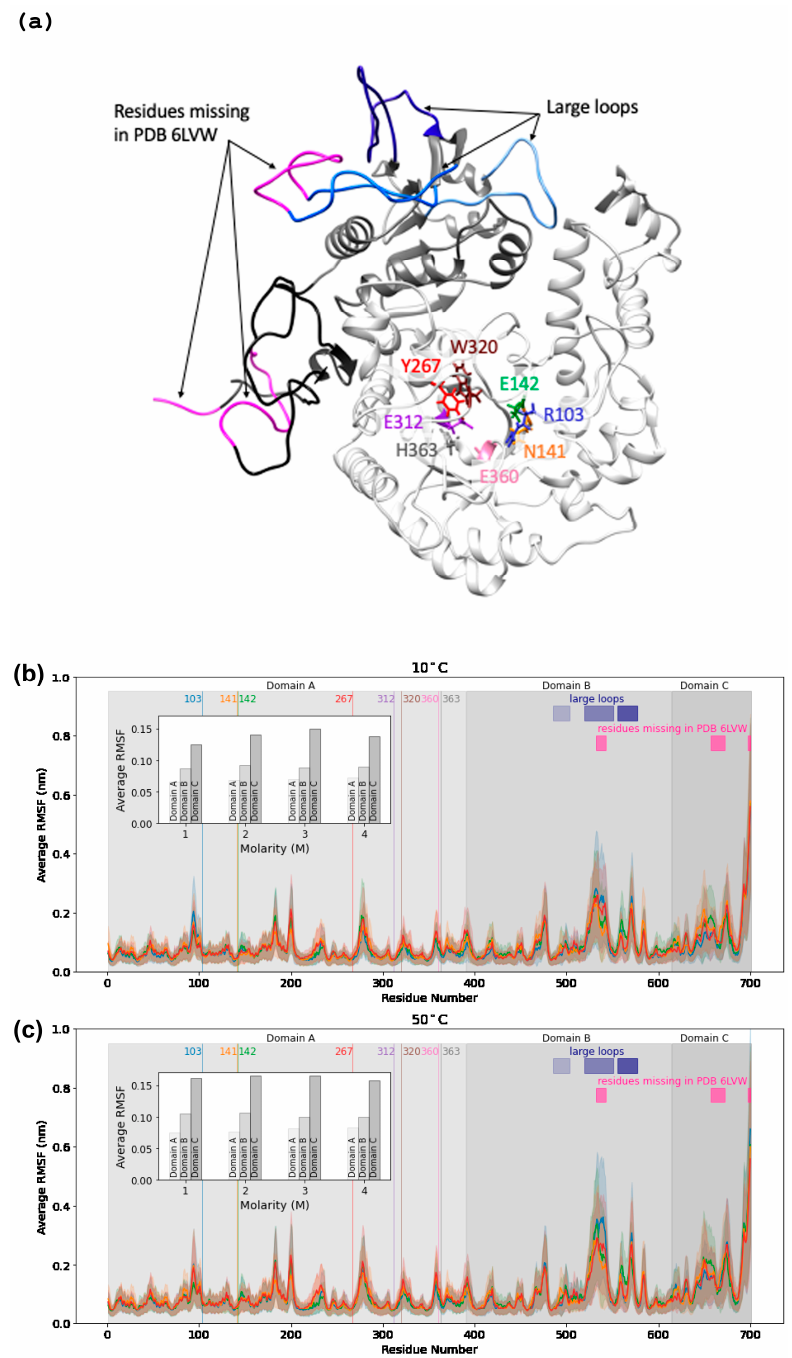
Figure 3. The structure of H. lacusprofundi β -galactosidase, with selected residues and domains labeled ( a ). RMSF profiles vs. sequence position for temperatures 10 ◦ C ( b ) and 50 ◦ C ( c ) with KCl molarities 1 M (blue), 2 M (green), 3 M (orange), and 4 M (red). Eight active site residues (103R, 141N, 142E, 267Y, 312E, 320W, 360E, 363H) are shown as vertical lines at their sequence positions. The three domains are shaded in light gray for domain A (residue 1–390), medium gray for domain B (residue 391–614), and dark gray for domain C (615–700). The averages of the average RMSF values per domain are shown in the inset graph on the upper left side of each graph. The sequence positions of the three large loops from domain B are shown using blue rectangles (residues 485–503, 519–551, 555–577). The sequence positions of the residues missing in the crystal structure are shown using pink rectangles (residues 532–543, 657–672, 697–700).